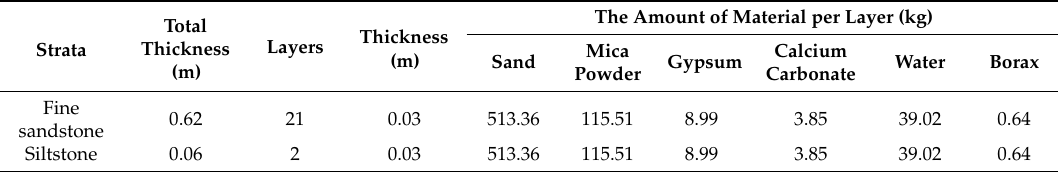
Table 2. The ratio and dosage of similar